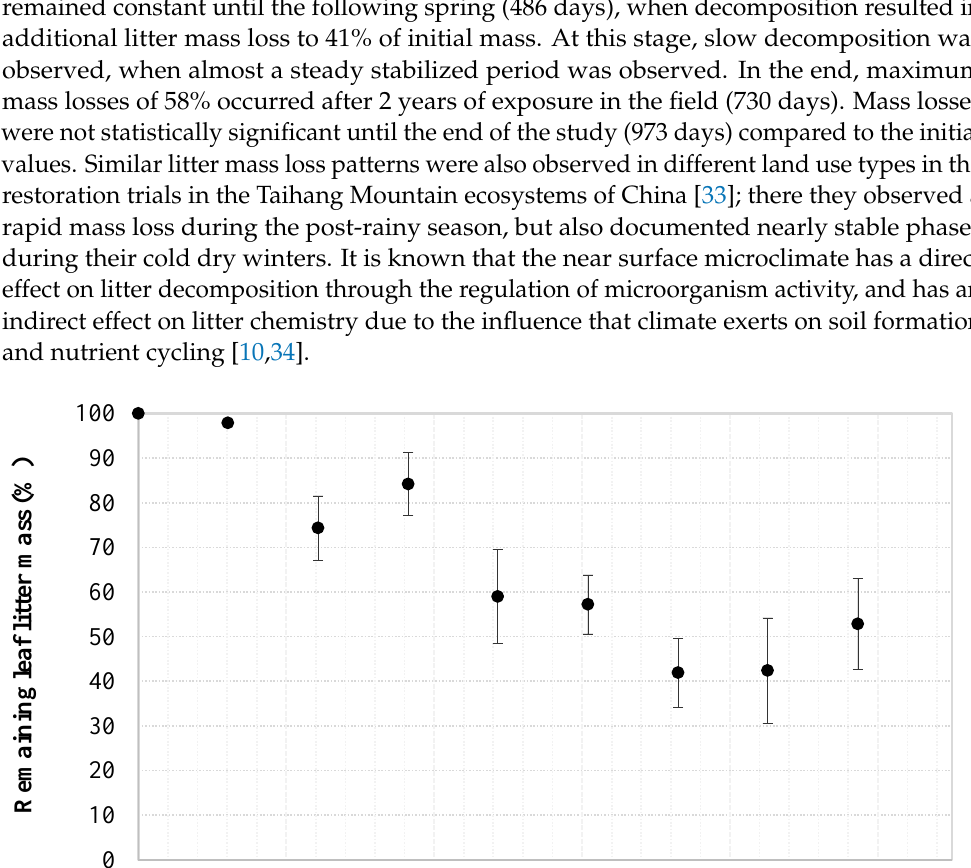
Figure 2. Remaining dry mass of decomposing leaf litter over time.